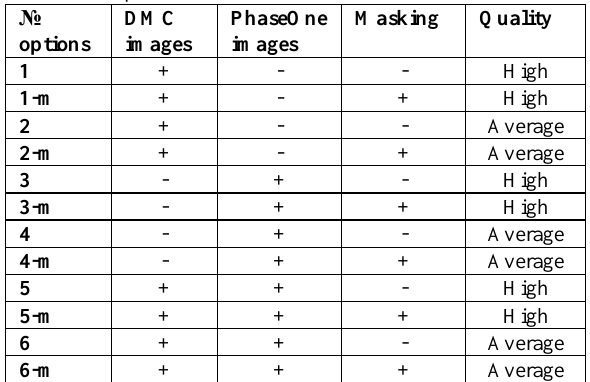
Table 2 . Aerial triangulation options.